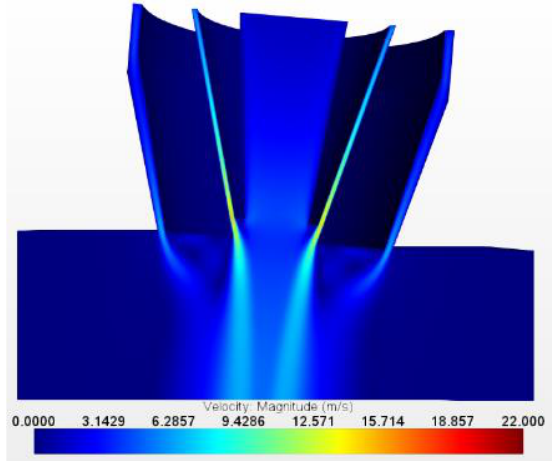
Figure 8: Simulation using condition